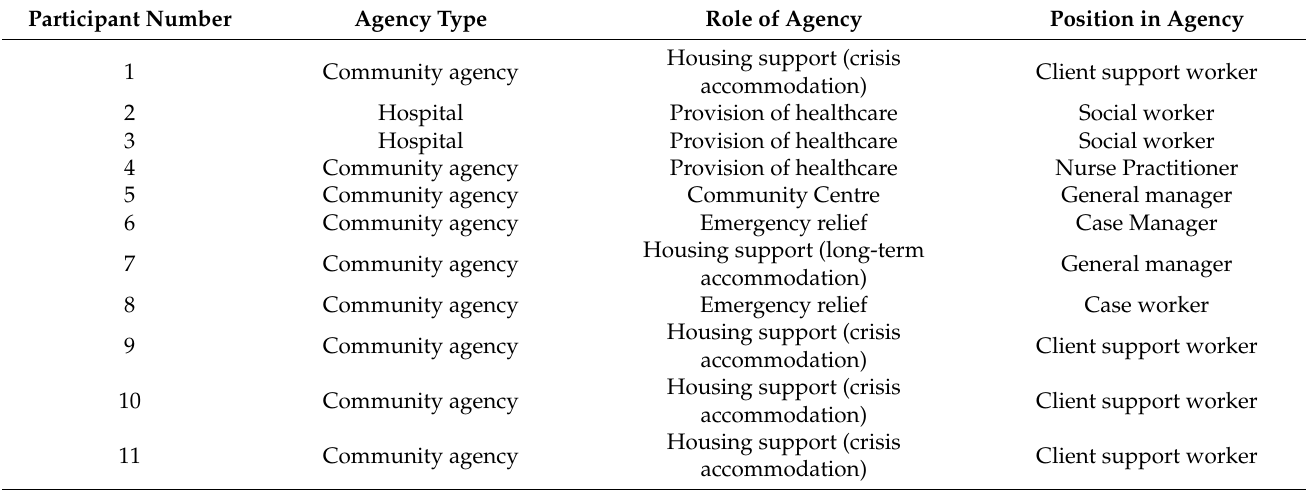
Table 2. Participant